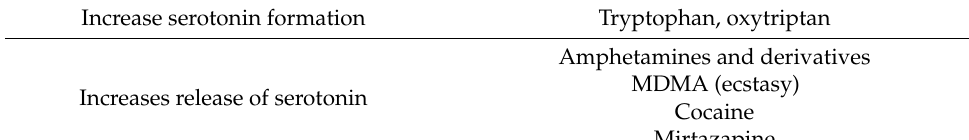
Table A1. List of drugs with Serotonergic Effects in Central Nervous